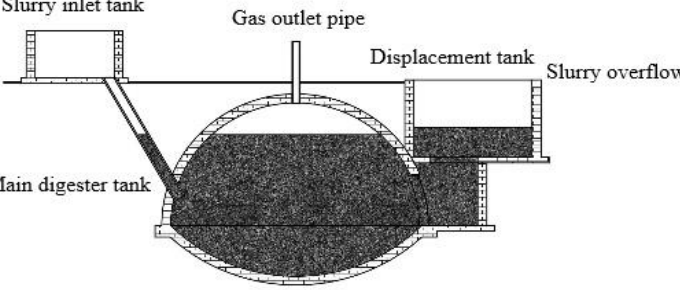
Figure 2. Example of a popular Chinese fixed-dome AD Facility [27] (Reproduced with permission from IDCOL, 2008).